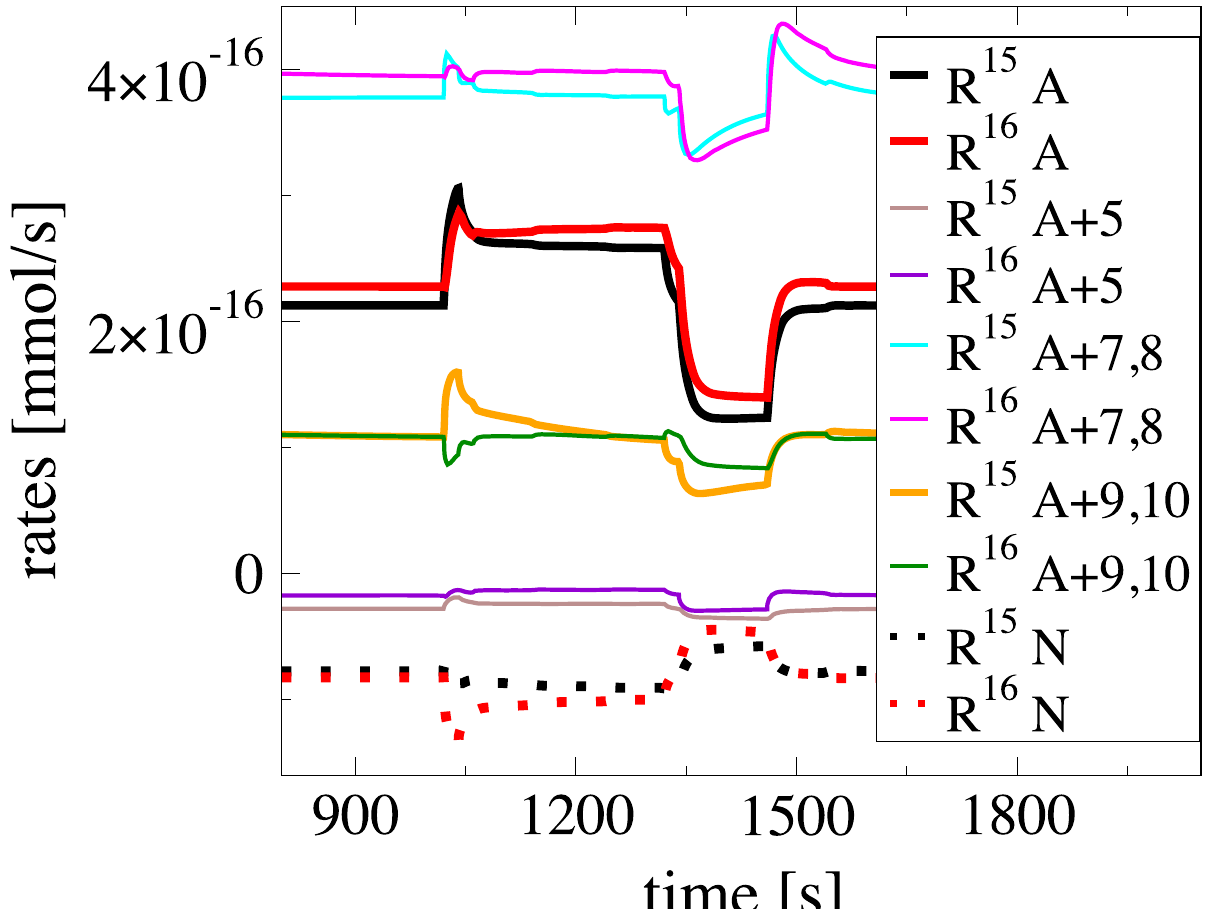
Fig 4. Evolution of R 15 and R 16 rates when applying the modifications leading from ANLS to NALS case, separately. Evolution of the net rates R 15 = R 15, f − R 15, b and R 16 = R 16, f − R 16, b , related to the Lac flow from astrocytes to interstitium and from there to neurons, in the ANLS (A) and NALS (N) cases. In the ANLS case R 15 and R 16 are positive, while in the NALS case are negative. The net rates R 15 and R 16 are also displayed in the case were each of the modifications leading from the ANLS to the NALS configuration is implemented separately. These modifications relate to changes in the parameters of reactions 3, 5, 7, 8, 9 and 10; the profiles related to the modification of reaction 3 are not shown, since the differences with the ANLS case are